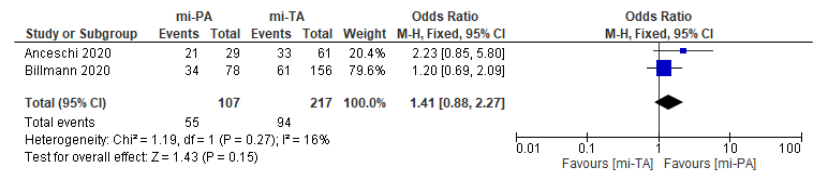
( a ) Forest plot representing analysis of patients with complete clinical success according to PASO criteria.